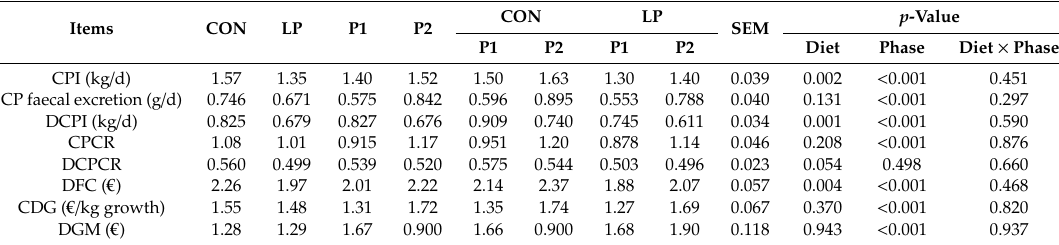
Table 4. The e ff ects of high protein (CON) and low protein (LP) diets during growing (P1) and finishing (P2) phases, on crude protein (CP) intake (CPI), digestible CPI (DCPI), CP conversion ratio (CPCR), digestible CPCR (DCPCR), daily feed cost (DFC), cost of daily gain (CDG) and daily gross margin (DGM) values of young Charolais beef bulls at Rovigo Province, Italy.